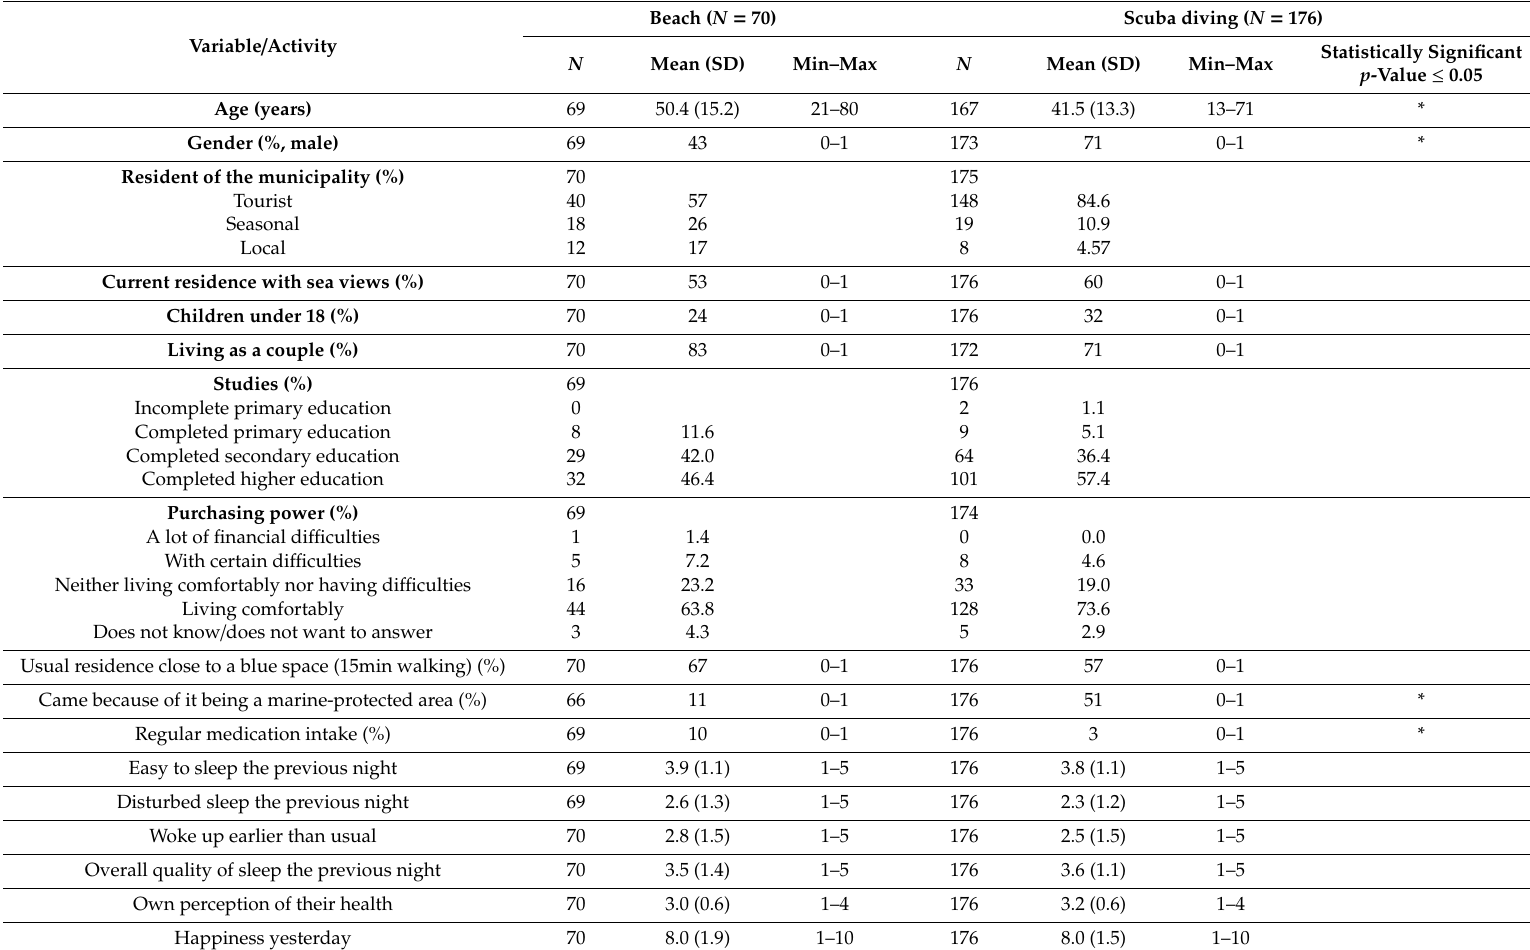
Table 2. Descriptive data of the study population a